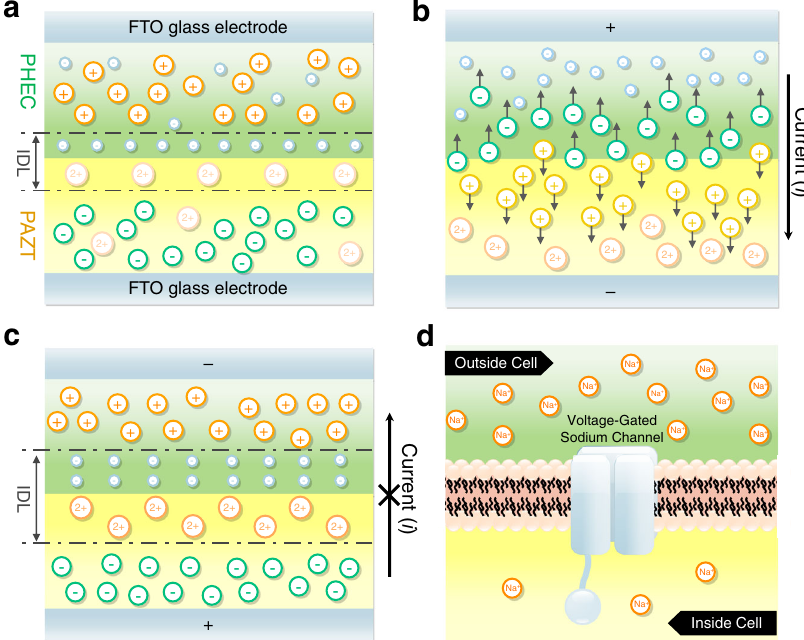
Fig.1|WorkingmechanismofGPEionicdiode.a schematicofGPEionicdiodewithoutvoltagebias; b underforwardbias; c underreversebias; d schematicofbiological neuron ion